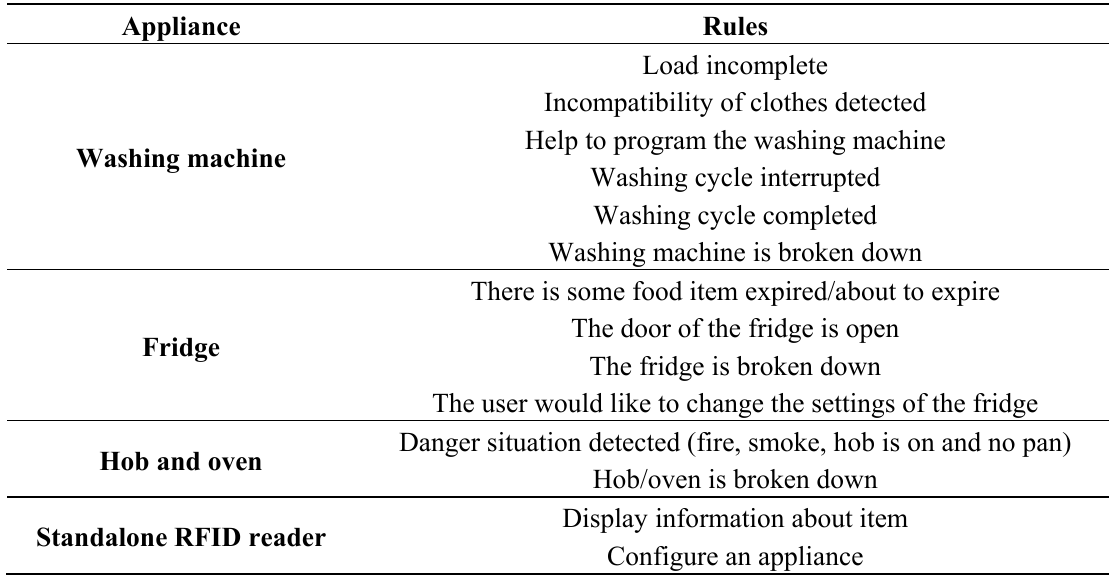
Table 1. Rules categorized by